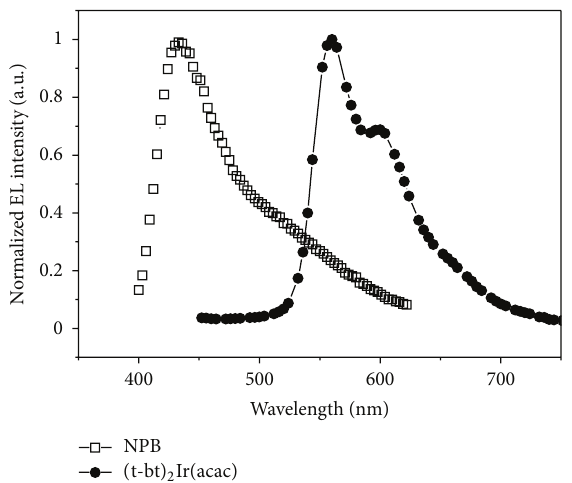
Figure 2: Normalized EL spectra of NPB and (t-bt) 2 Ir(acac) ma- terial, the emission spectra were testing results of organic device structureITO/CuPc/NPB/BCP/Alq/LiF/ALandITO/NPB/CBP: (t- bt) 2 Ir(acac)/BCP/Alq/LiF/AL, respectively.